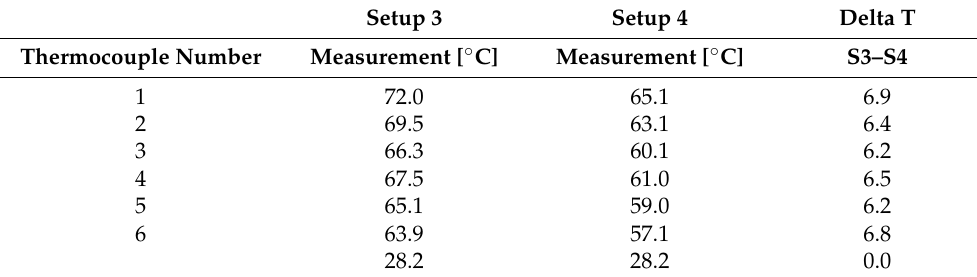
Table 8. Temperature measurements for Setup 3 and Setup 4 with adjusted temperatures for Setup 4.